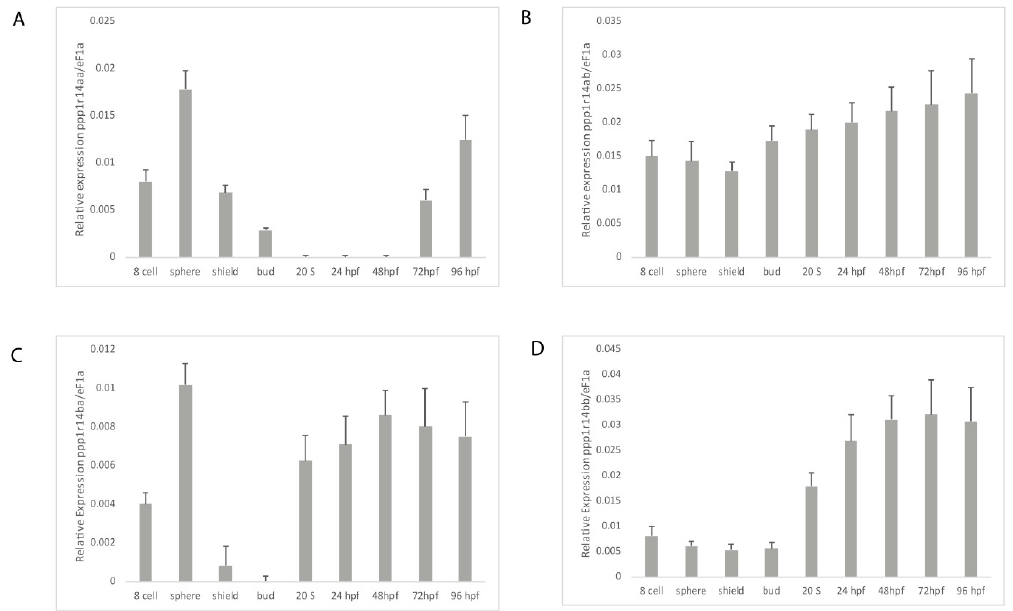
Figure 5. Expression of ppp1r14a and ppp1r14b paralogs during early embryonic development in zebrafish. Embryos were collected shortly after fertilization (8 cell), at sphere stage (4 hpf), shield stage (6 hpf), bud stage (10 hpf), 20 somite stage, Prim-5 stage (24 hpf), long-pec stage (48 hpf), protruding-month stage (72 hpf), and day 4 (96 hpf). Amplification of eF1a and total RNA without addition of reverse transcriptase were used as positive and negative controls, respectively. (A) Gene specific primers were used to detect ppp1r14aa ( A ), ppp1r14ab ( B ), ppp1r14ba ( C ), or ppp1r14bb ( D ). Values are means of three biological replicates performed in duplicate. Error bars represent standard deviation. All values are reported as expression relative to ef1a .